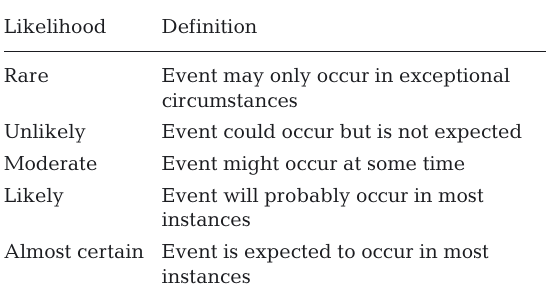
Table 3. Definitions of levels of estimated